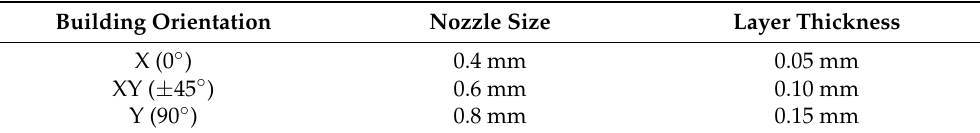
Table 1. Parameters of printed samples.